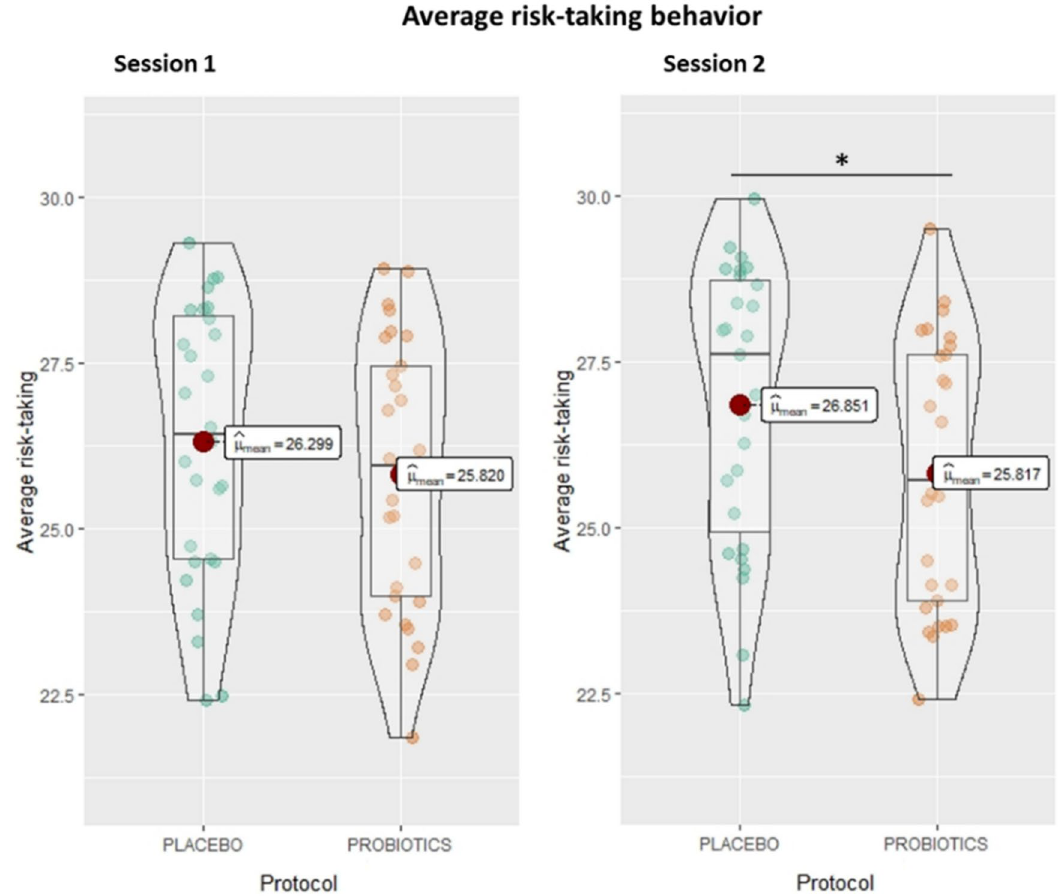
Figure 4. Average risk-taking behavior (n = 57). Average risk-taking estimated by the average standard deviation of each participant’s choice across sessions and protocols (placebo in green and probiotics in orange). The MGT allows risk scores from 1.8 to 50. The present analyses show participants’ average risk-taking scores. Average risk-taking scores vary between 21.84 and